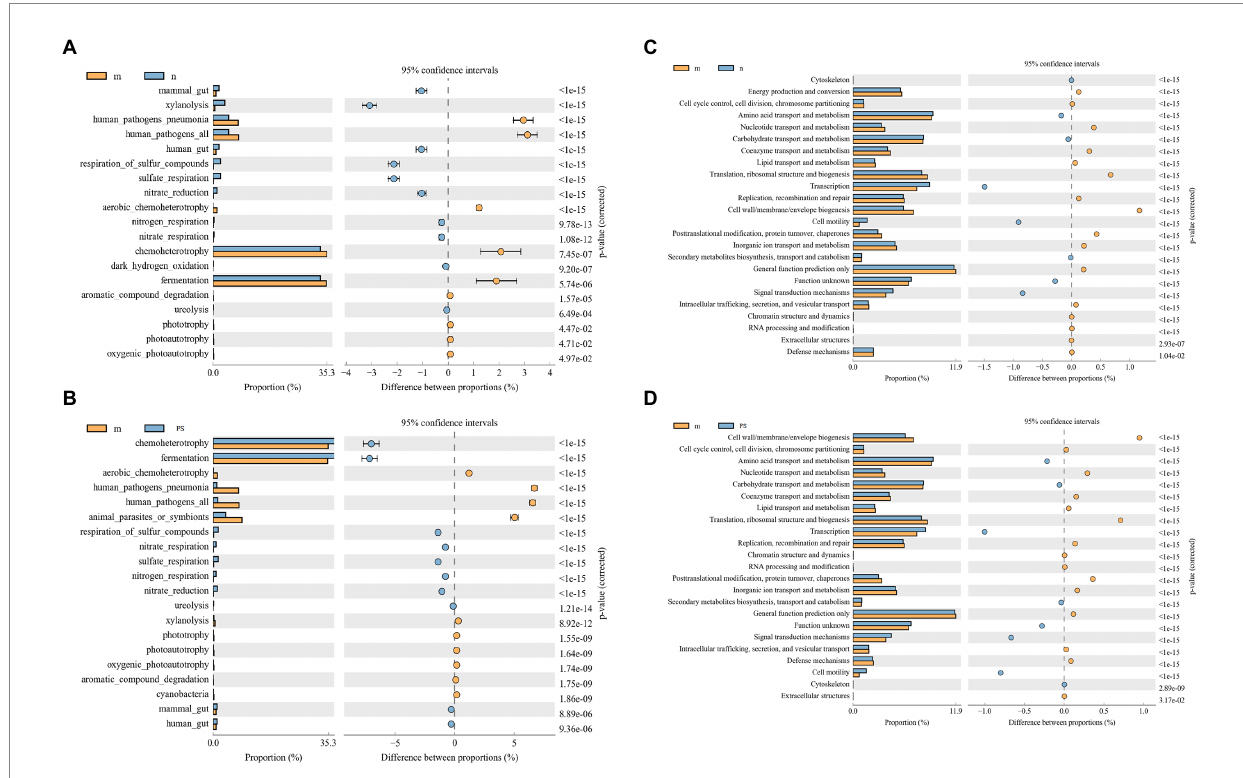
FIGURE 8 Postbiotic of hawthorn-probiotic reduces the pathogenic microbial pathway and increases the cell activity pathway by enrichment analysis. (A) The FAPROTAX Ecological function forecast between M and N; (B) the FAPROTAX Ecological function forecast between M and FS; (C) COG functional classification statistical chart between M and N; (D) COG functional classification statistical chart between M and FS. The figure on the left shows the abundance ratio of different functions in two samples or groups of samples. In the middle is the proportion of differences in functional abundance within the 95% confidence interval. The rightmost value is a value of p